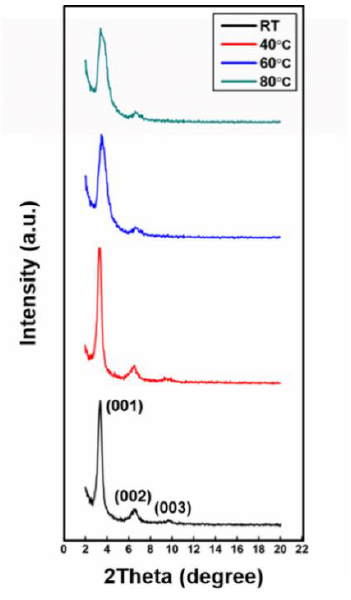
Figure 4. Out-of-plane grazing incidence X-ray diffraction (GIXD) images of 29-DPP-SVS polymer films blade-coated with substrate temperature at RT (black), 40 °C (red), 60 °C (blue) and 80 °C (dark cyan).